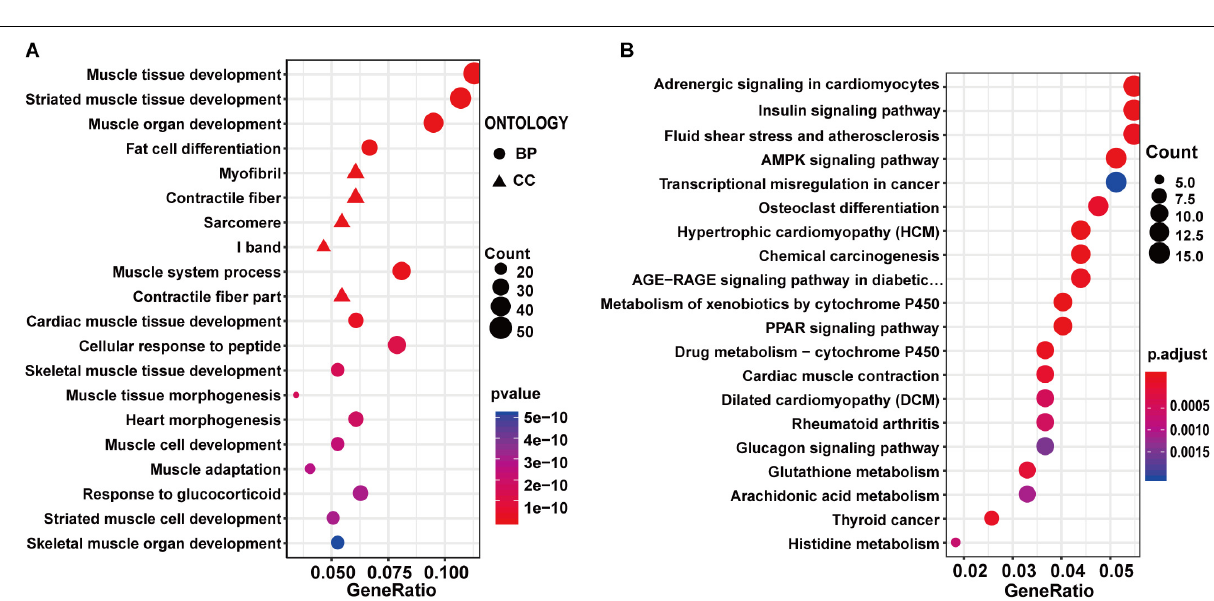
FIGURE 2 | GO and KEGG enrichment analysis of DEGs in GK vs. Wistar comparison. The top 20 significantly enriched GO terms (A) and KEGG pathways (B) .